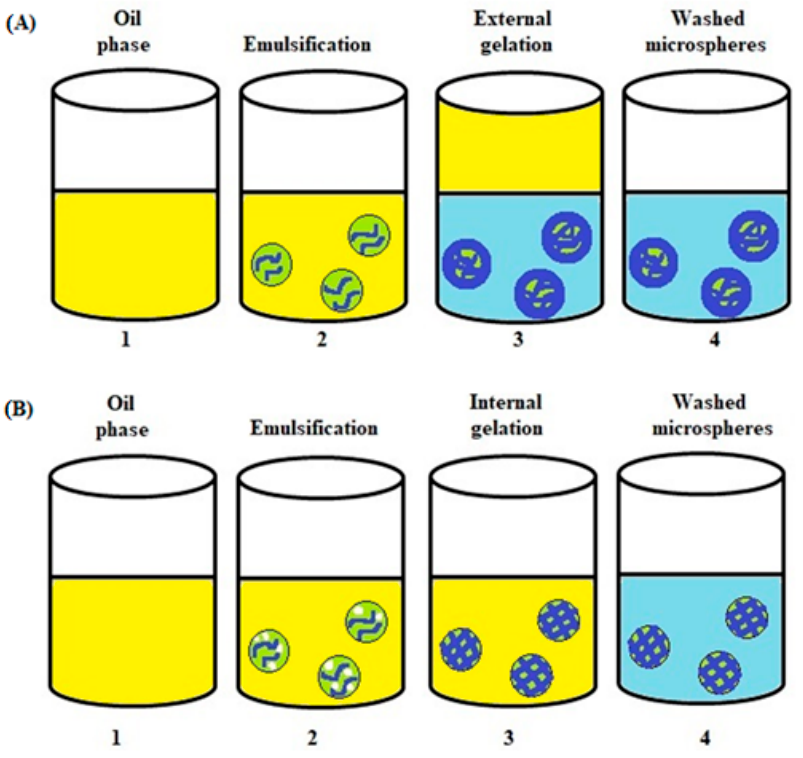
Figure 5. Schematic representation of microsphere formation with emulsification coupled with external ( A ) and internal gelation ( B ). ( A ) 1. Continuous oil phase. 2. Emulsifying an alginate solution in the oil phase (creating a W/O emulsion). 3. Addition of CaCl 2 solution to the oil phase (external gelation of the alginate microspheres). 4. Washed alginate microspheres. ( B ) 1. Continuous oil phase. 2. Emulsifying an alginate solution (containing an insoluble calcium source) in the oil phase (creating a W/O emulsion 3. Solubilization of the calcium source by adding acid and lowering the pH inside the beads (internal gelation of the alginate microspheres). 4. Washed alginate microspheres.